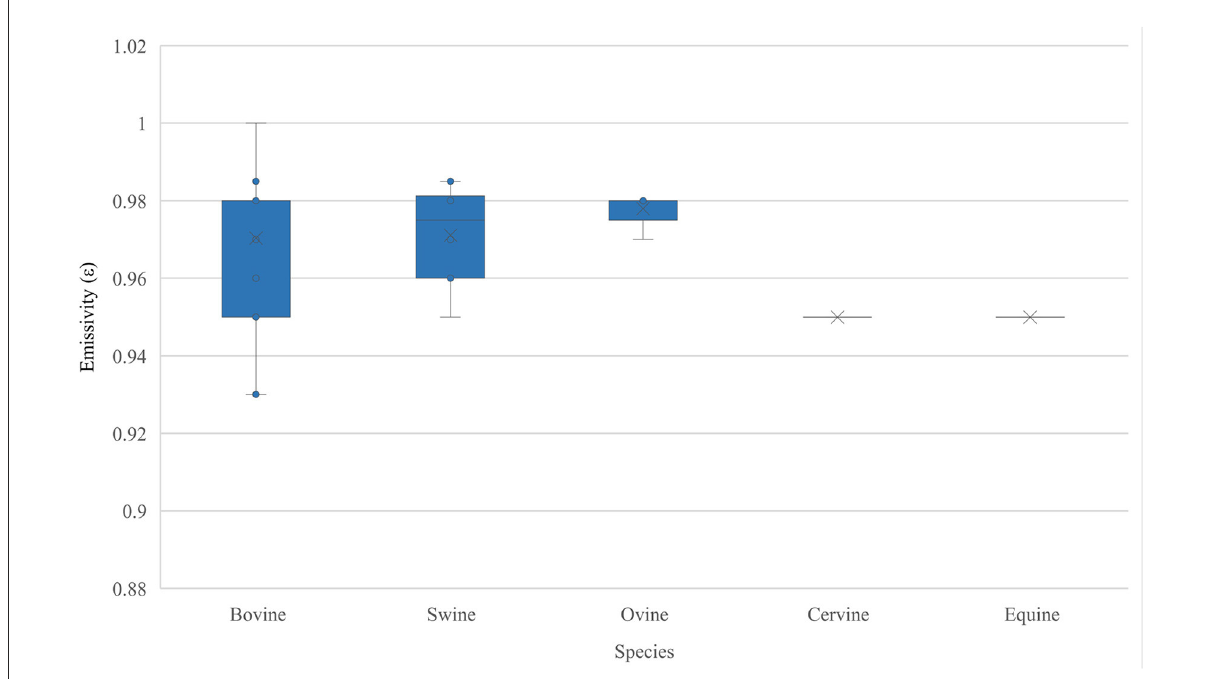
FIGURE4 Range of emissivities ( ε ) used across species in the articles in the